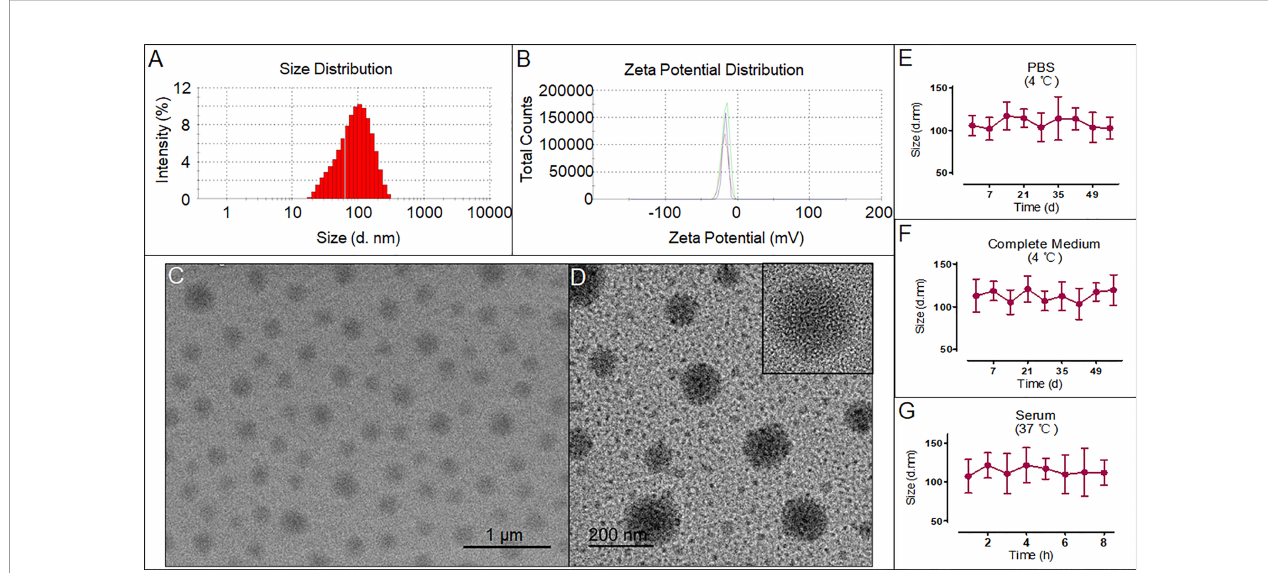
FIGURE 1 | The characteristics and morphology of the DIST NPs. The size distribution (A) and zeta potential distribution (B) of the DIST NPs. The TEM (C) and high-resolution TEM (D) results of the DIST NPs. The colloid stability evaluated by the size change of the DIST NPs in various solvent and temperature environments. The quantitative experiment was repeated three times (E – G)